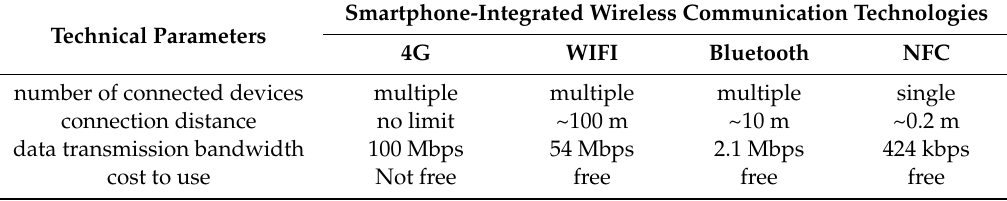
Table 1. Technical parameters of smartphone-integrated wireless communication technologies.